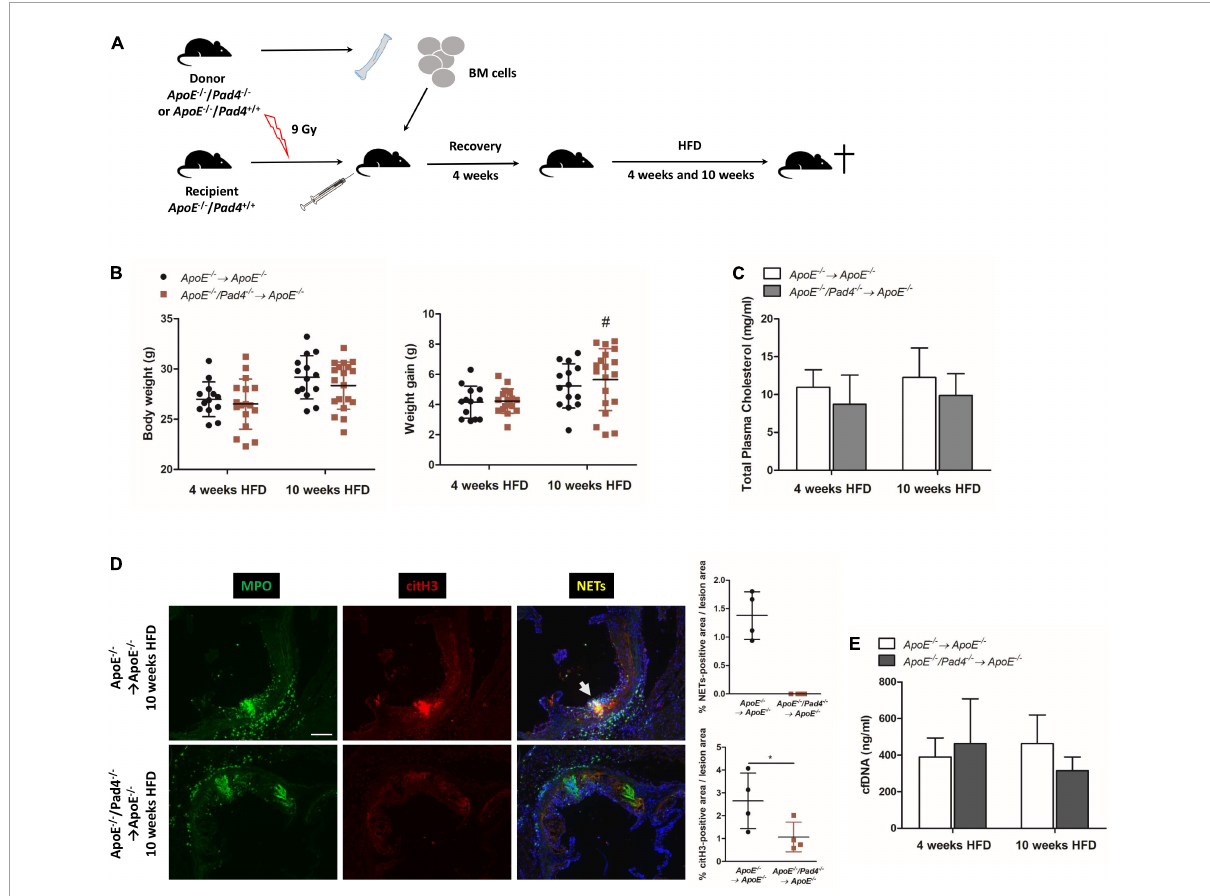
FIGURE1 Impact of bone marrow-restricted PAD4 deficiency on body weight and NETs formation after high-fat diet. (A) Schematic of the experimental design. (B) Body weight and weight gain of mice fed a high-fat diet (HFD) for 4 or 10 weeks, respectively. n = 13–19/group. (C) Plasma cholesterol levels after HFD. n = 4–8/group. (D) Representative immunofluorescence images of aortic root sections from mice on HFD for 10 weeks stained for MPO ( green ) and citrullinated histone H3 ( red ) representing NETs ( yellow ). Representative images from four mice per group. Scale bar: 100 µ m. Percentage of NETs-positive and citH3-positive area were calculated. n = 4/group. (E) cfDNA was quantified in plasma of mice after 4 and 10 weeks of HFD, respectively. n = 8/group. # p < 0.05 vs. 4 weeks HFD; * p < 0.05.